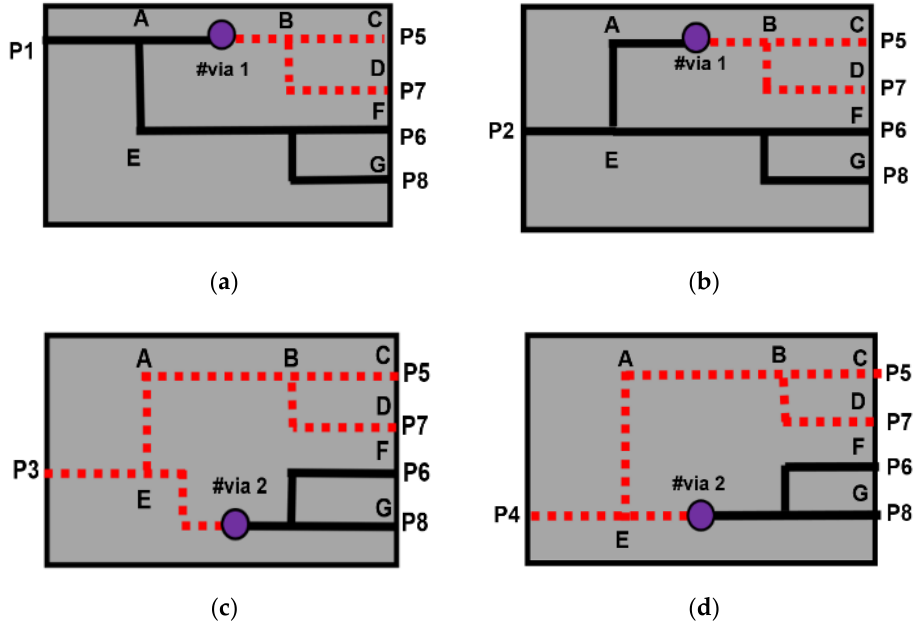
Figure 10. Current signal flow when input fed to: ( a ) port 1, ( b ) port 2, ( c ) port 3, and ( d ) port 4.